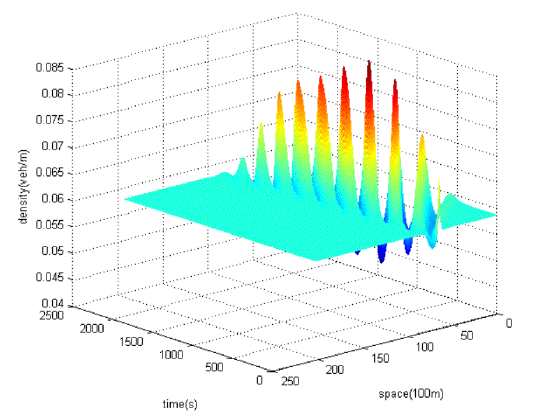
Fig. 2. Density space-time diagram with Hopf branch as initial